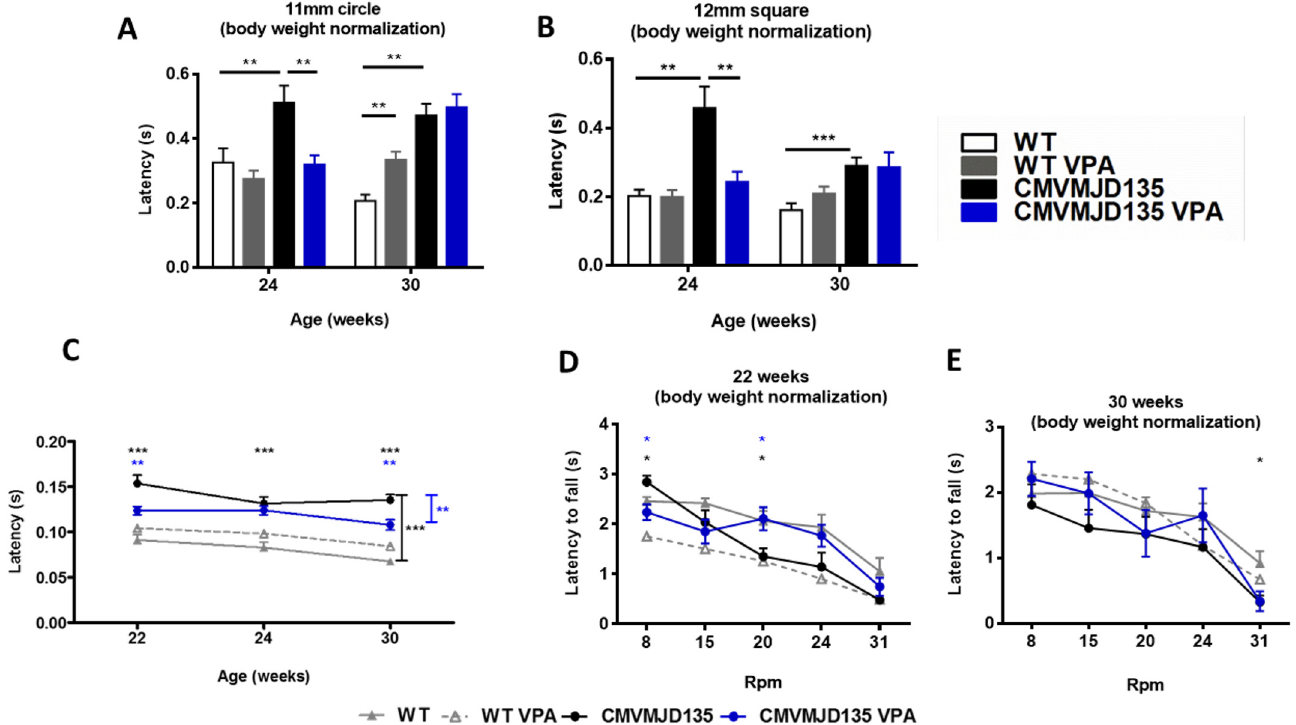
Fig 4. Balance and motor coordination performance normalized for animal body weight. (A,B) No differences were observed between non-normalized and normalized performance for body weight in balance beam walk test; (C) improvement motor swimming test at 22 and 30 weeks of age and (D) improvement at 22 weeks of in 8 and 20 rpm of Rotarod test. Bars represent the mean ± SEM (WT veh, n = 10; WT VPA, n = 15, CMVMJD135 vehicle, n = 10; CMVMJD135 VPA, n = 13), * represent p < 0.05, ** represent p < 0.01 and *** represent p < 0.001, black asterisks represents the difference between WT and CMVMJD135, blue asterisks represents the difference between non-treated and VPA-treated CMVMJD135, (Repeated-measures ANOVA, Tukey correction for continuous variables, One-Way ANOVA for differences between groups in specific ages of the continuous variables and Mann-Whitney U test for continuous variables without normal distribution